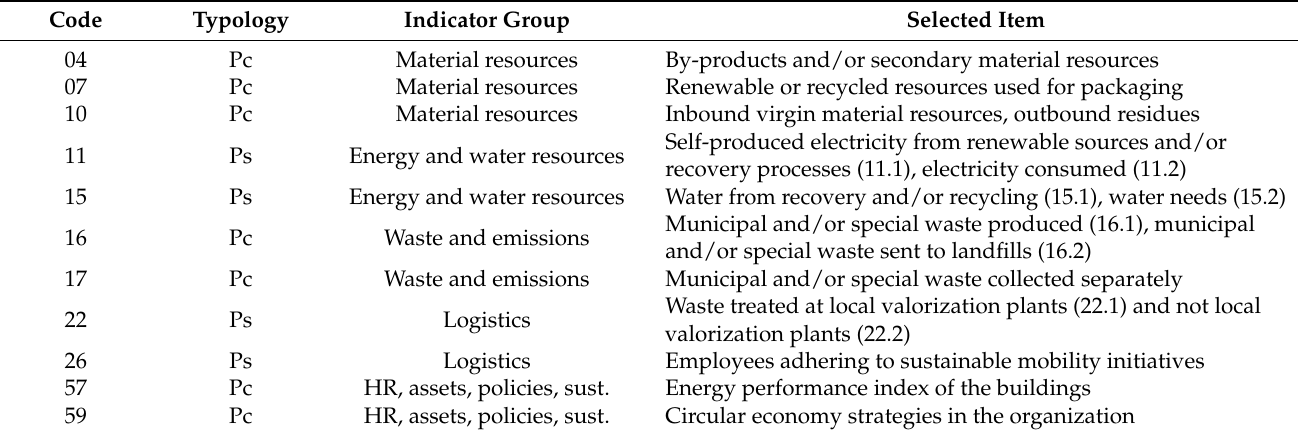
Table 3. Selected Indicators for the Users’ Perception and Awareness